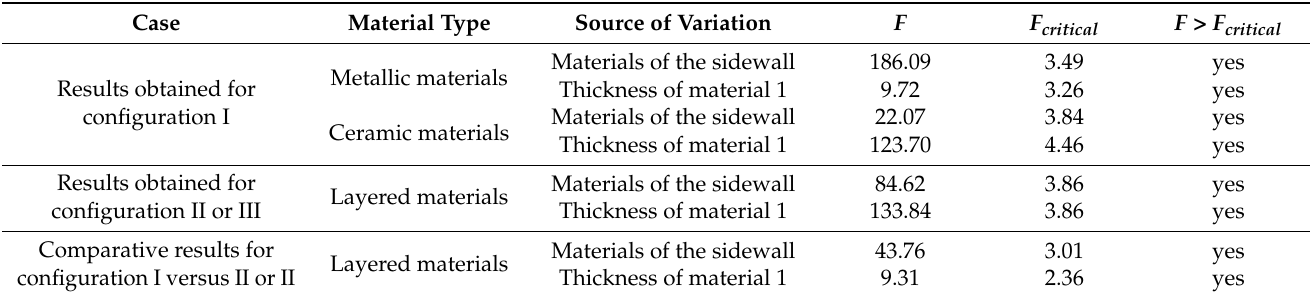
Table 11. Two-way ANOVA applied to the results of heating